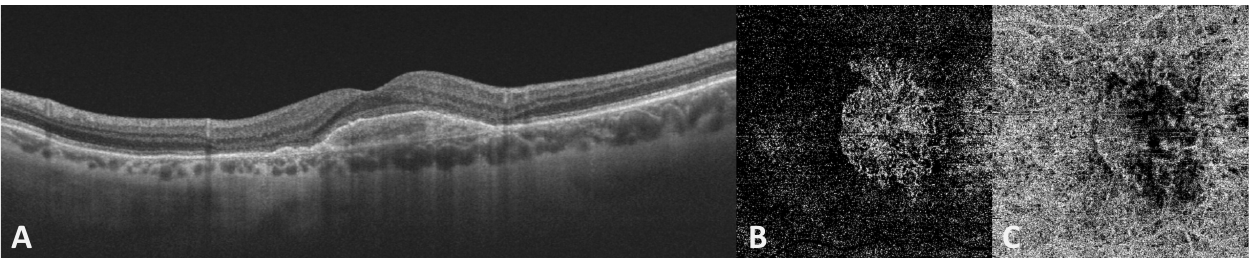
Figure 4. Left eye of a 72-year-old female patient with neovascular AMD previously treated with 10 intravitreal injections of anti-VEGF. ( A ) Optical coherence tomography (OCT) B-scan centered on the fovea showing a subfoveal fibrovascular PED with no signs of active exudation. ( B , C ) OCT-angiography (OCT-A) 4.5 × 4.5 mm macular slab segmented at the outer retina ( B ) and choriocapillaris ( C ) level showing the presence of MNV. AMD: age-related macular degeneration; PED: pigment epithelium detachment; MNV: macular neovascularization.